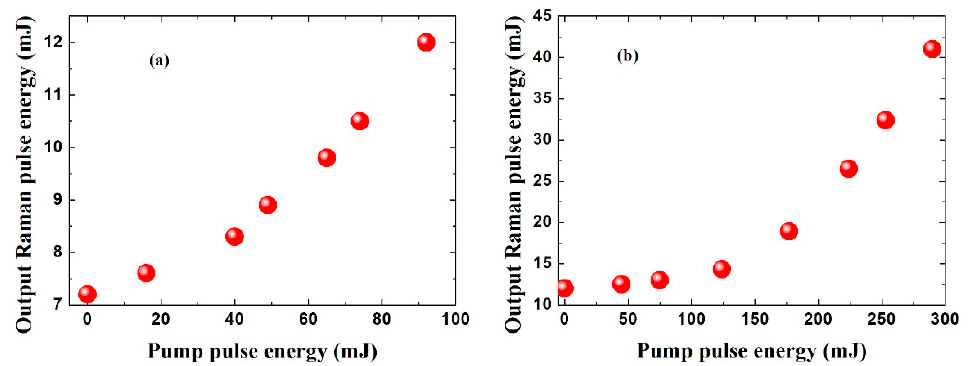
Figure 4. Output Raman pulse energy versus pump pulse energy of the Raman power amplifiers: ( a ) first-stage and ( b ) second-stage.